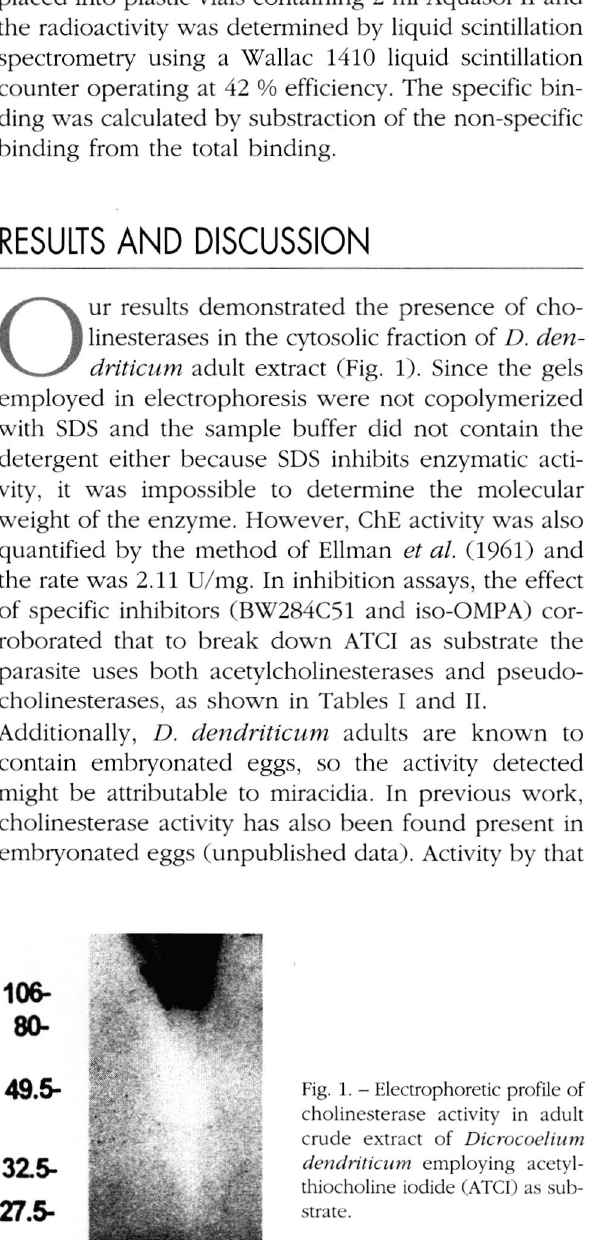
Fig. 1. - Electrophoretic profile of cholinesterase activity in adult crude extract of Dicrocoelium dendriticum employing acetyl- thiocholine iodide (ATCI) as sub